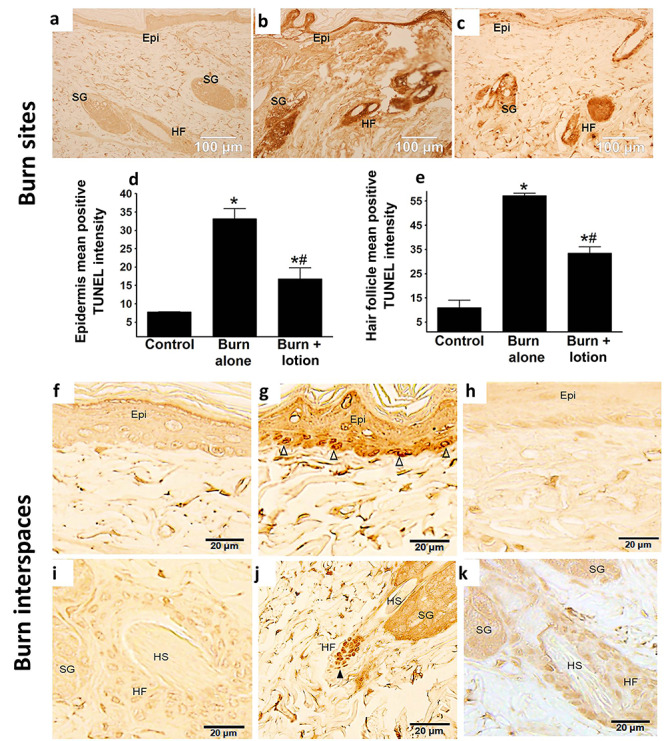
 LF lotion reduces the burn-induced apoptosis in the burn sites and interspaces. (a–c) Representative micrographs of deoxynucleotidyl transferase biotin-d-UTP nick-end labeling (TUNEL) staining in the burn site showing extensive labeling in the epidermis, hair follicles and sebaceous glands in burn-alone animals but significantly less staining in controls and Livionex formulation (LF) lotion-treated animals. (a) Control, with neither burn nor any lotion; (b) burn site 72 hours post-burn alone; (c) burn site 72 hours post-burn plus topical application of LF lotion every 8 hours starting 5 minutes after the burn; (d) mean positive TUNEL intensity of epidermis; (e) mean positive TUNEL intensity of hair follicles. TUNEL staining in interspace epidermis (f–h) and hair follicle (i–k), showing strong TUNEL-positive labeling of individual epithelial nuclei scattered over the basement of the epidermis (g) or focused on the hair follicles (j) of burn-only animals. The control sections (panels (f) or (i)) and LF lotion-treated sections (panels (h) or (k)) showed very few positive TUNEL-stained individual epithelial nuclei in the epidermis (panels (f) and (h)) and hair follicles (panels (i) and (k)). (f) and (i), sham control; (g) and (j), 72 hours post-burn alone; (h) and (k), 72 hours post-burn and topical application of LF lotion every 8 hours starting 5 minutes right after the injury. *p < 0.05, vs. control, #p < 0.05 vs. burn alone. Scale bar = 100 μm in (a–c), 20 μm in (f–k). Open triangles Δ indicate basal cells with TUNEL-positive staining, black triangles ▲ point to the hair follicle epithelial cells with TUNEL-positive staining. Ep, epidermis, SG, sebaceous gland, HF hair follicles, HS hair shaft